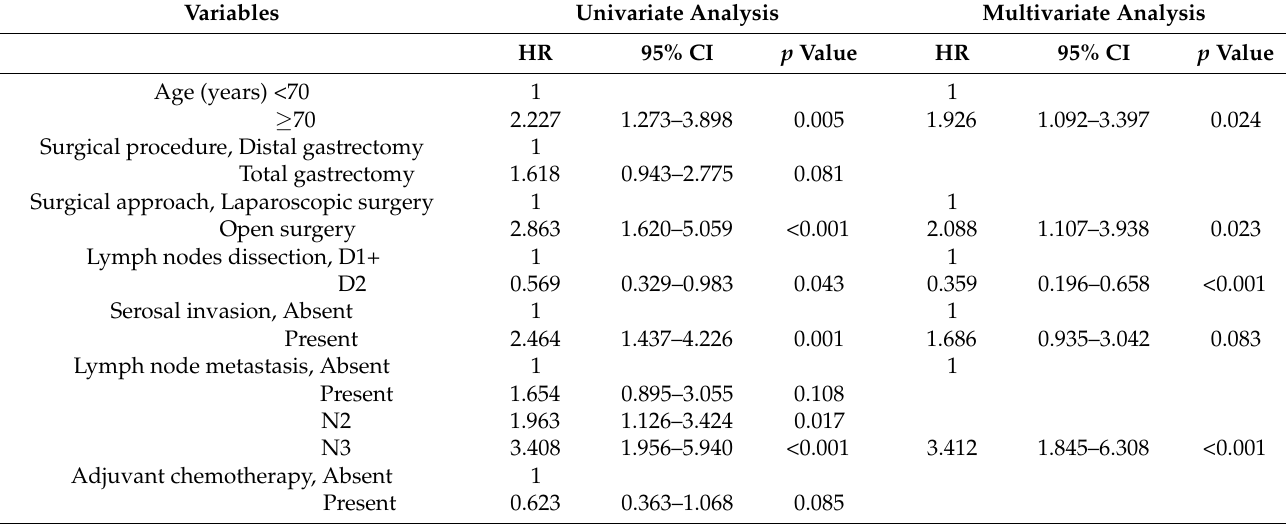
Table 3. Results of univariate and multivariate analyses of prognostic factors for overall survival in